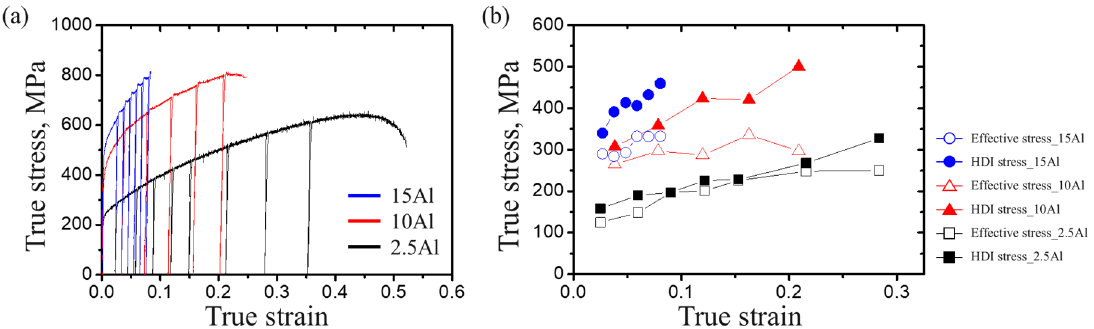
Figure 6. ( a ) Mechanical response during loading-unloading-reloading (LUR) cyclic deformation and ( b ) measured hetero- deformation induced (HDI) stress and effective stress of the present alloys.